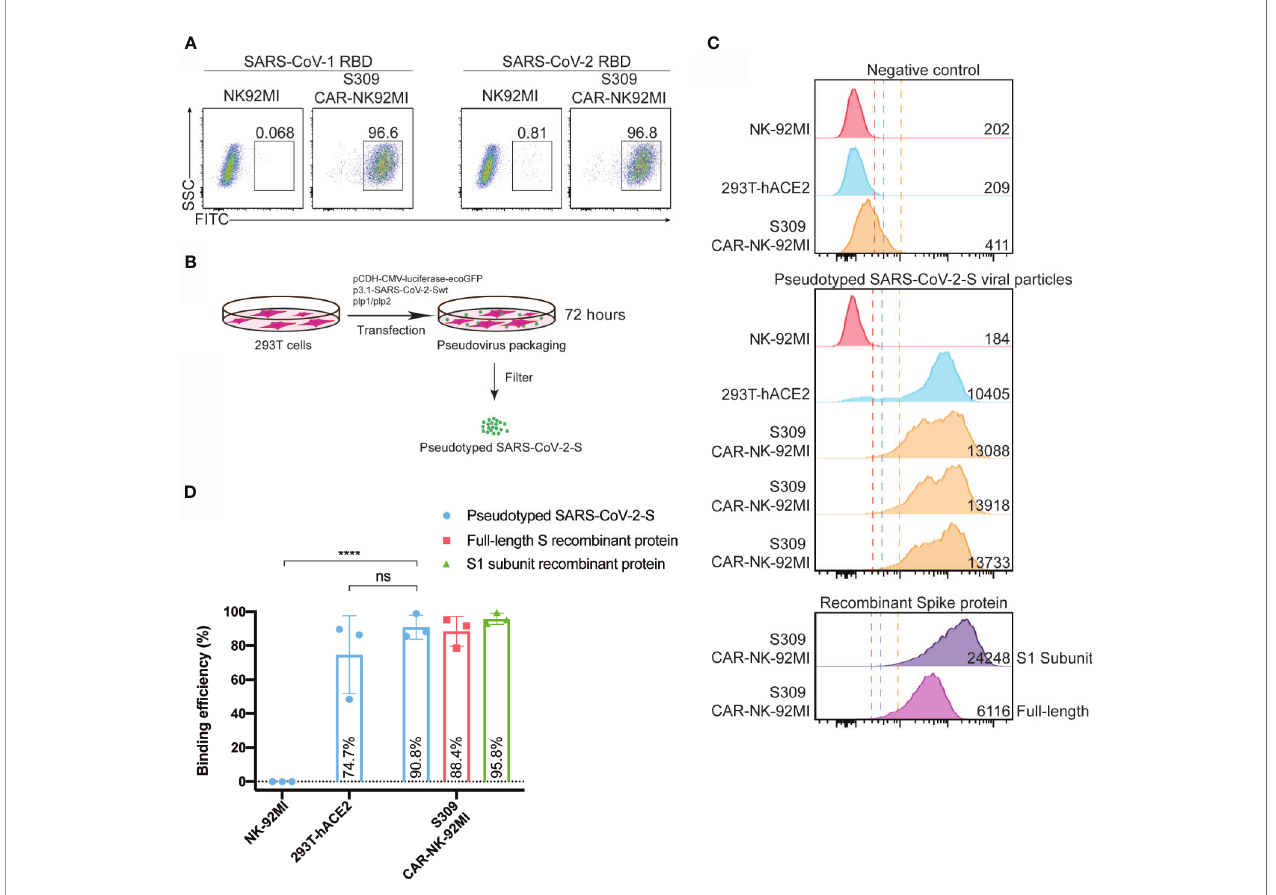
FIGURE 2 | S309-CAR-NK-92MI cells bind to RBD domain of SARS-CoV-2 S protein and pseudotyped SARS-CoV-2 viral particles. (A) Representative dot plots showing the ef fi ciency of S309-CAR binding to SARS-CoV-2-RBD. S309-CAR-NK-92MI or WT NK-92MI cells were incubated with the RBD recombinant protein of SARS-CoV-1 or SARS-CoV-2. (B) Generation of pseudotyped SARS-CoV-2 viral particles. 293T cells were transfected with various plasmids for 72 hours for the generation of pseudotyped SARS-CoV-2 viral particles. (C) Representative histogram showing S309-CAR-NK-92MI binds to the pseudotyped SARS-CoV-2 viral particles. S309-CAR-NK-92MI, parental NK-92MI, or 293T-hACE2 (positive control) cells were incubated with pseudotyped SARS-CoV-2 viral particles, S1 subunit, or full-length S recombinant protein at 37°C for 1 hour. The experimental sample was performed in triplicates with MFI = 13579 ± 251 (a.u.). (D) Quantitative data of the binding ef fi ciency of S309-CAR-NK-92MI cells to pseudotyped SARS-CoV-2 viral particles. The experimental sample was performed in triplicates with binding ef fi ciency of over 90%. Data represent means ± standard error of the mean (SEM) of three independent experiments represented by each dot. Non-parametric test was employed for panel (D) . ns p > 0.05, and ****p <